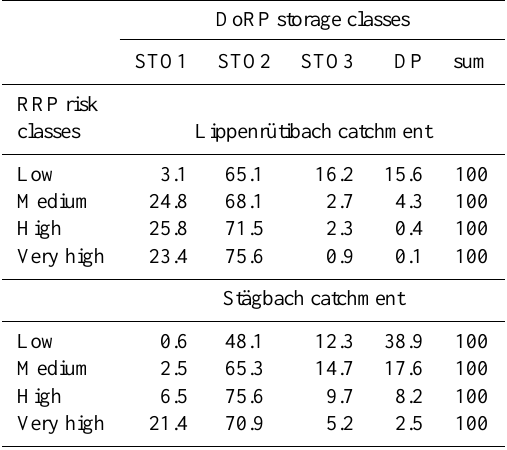
Table 3. Amount of RRP risk class pixel within the DoRP storage classes in percent of the total amount of pixel within one risk class [%]. The areal extent of the RRP risk classes during the large runoff events (Lippenrütibach: May 1999, Stägbach: June 2010; see Fig. 1) was taken for comparison. STO1 – low storage capacity, STO2 – intermediate storage capacity, STO3 – high storage capacity, DP – deep